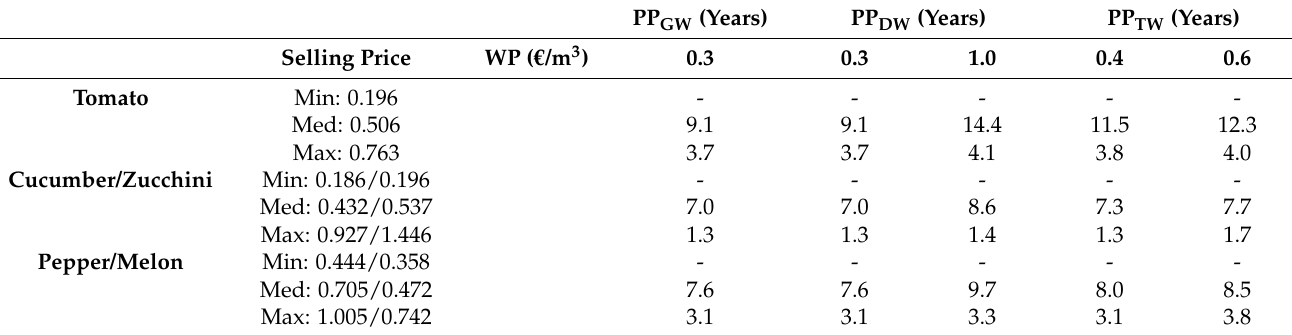
Table 10. PP of three different crop alternatives with diverse water